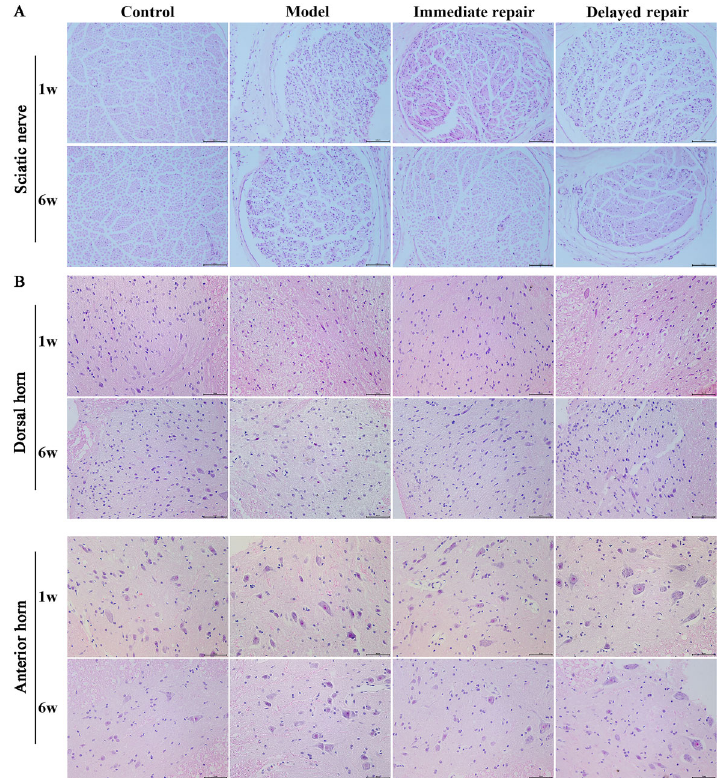
Figure 1. H&E staining was used to observe the pathological changes of the sciatic nerve ( A ) and spinal cord ( B ) after sciatic nerve injury in rats of different groups. Panel A, magni fi cation 200 (cid:1) ; scale bar 100 m m; panel B, magni fi cation 400 (cid:1) ; scale bar 50 m m.